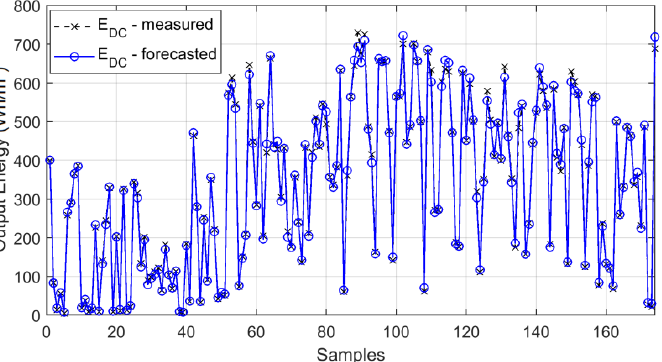
Figure 9. The values of ( E DC ) energy measurements and ( E DC ) energy forecasts obtained from the ANFIS (TSi) model (the training data set, 174 days).